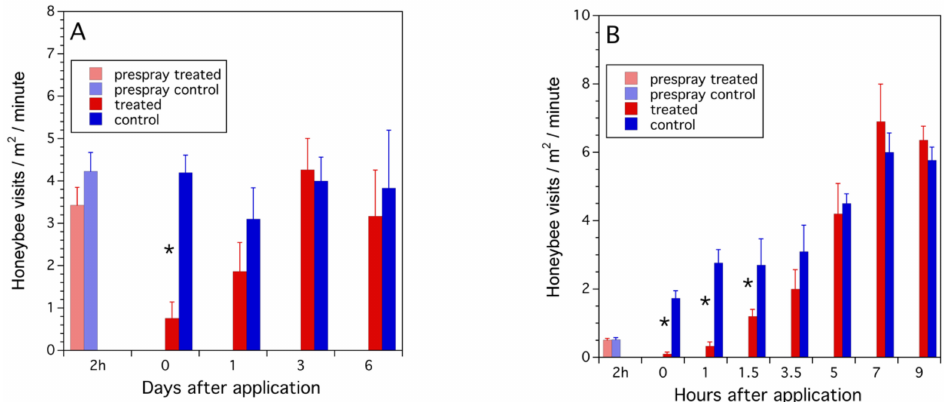
Figure 10. Field trial testing repellency of propiconazole to foraging honey bees, 2013 ( A ), and 2014 ( B ). Error bars are standard error of the mean and asterisks denote significant ( p < 0.05) pairwise differences in mean foraging honey bee densities between the two treatments (fungicide application and water control) within sampling